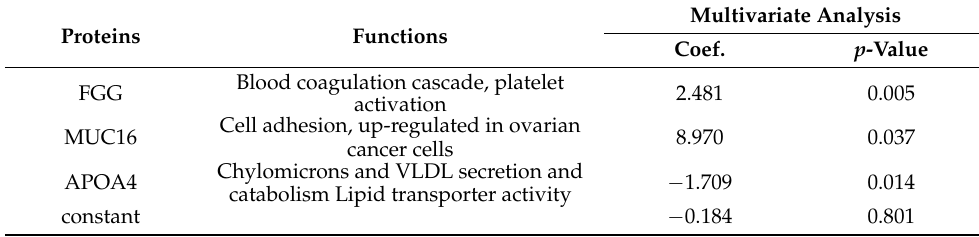
Multivariate Analysis